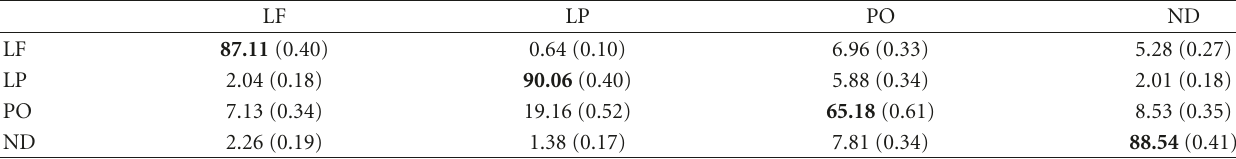
Table 2: The same as in Table 1, but now for a majority vote involving classifications based on each fluctuation analysis separately.